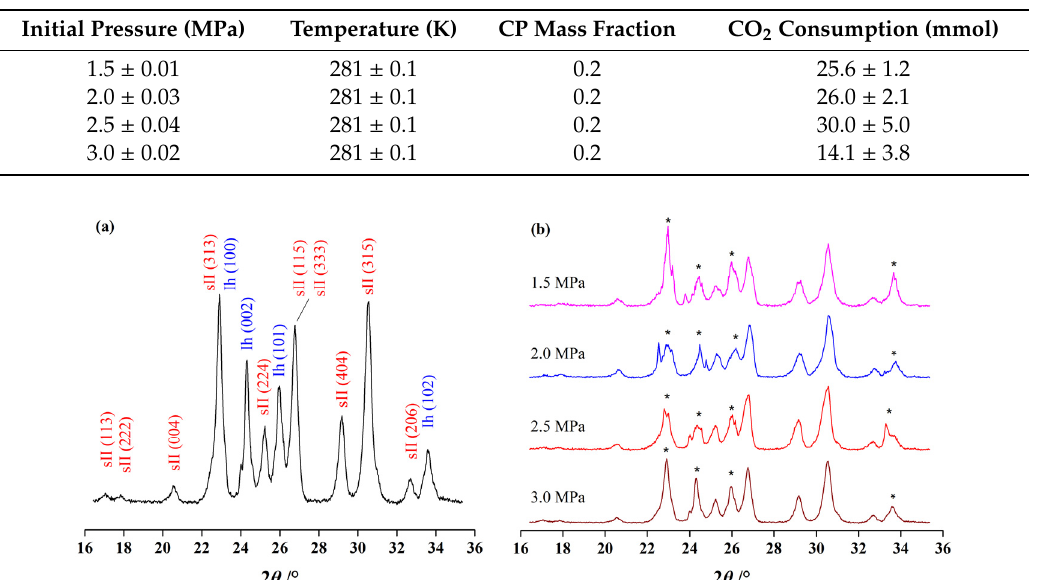
Figure 5. Pressure ( a ) and CO 2 consumption ( b ) profiles in the formation of mixed CP ‐ CO 2 hydrates.